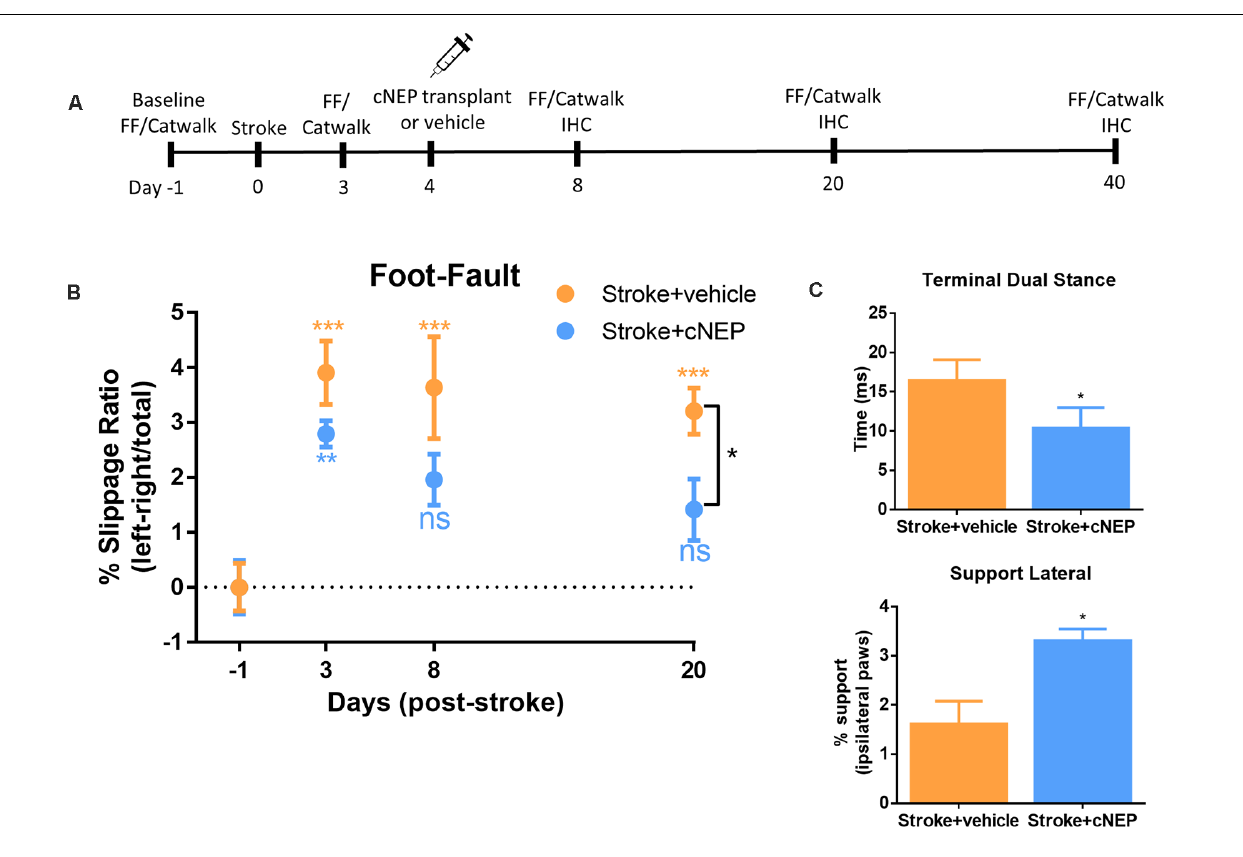
FIGURE 2 | cNEP transplantation improves motor outcomes of stroke by PSD20. (A) Schematic of experimental paradigm. FF, foot-fault and IHC, immunohistochemistry. (B) The percent slippage ratio was scored in Stroke + vehicle and Stroke + cNEP treated mice. Both groups display a motor deficit on PSD3 and PSD8 compared to baseline performance. Stroke + cNEP mice recover by PSD8 and PSD20 when compared to baseline and is significantly improved compared to Stroke + vehicle mice (Student’s T -test, Mann–Whitney post hoc ). Stroke + vehicle mice maintain the stroke motor deficit on PSD8 and PSD20, compared to baseline. Stroke + cNEP ( n = 10 mice); Stroke + vehicle ( n = 10 mice) Two-way ANOVA, Tukey’s post hoc . (C) Catwalk was used to measure gait parameters after stroke with or without cNEP transplantation. Terminal dual stance measures the duration (ms) of simultaneous contact of both hindpaws. The duration of the left hindlimb terminal dual stance was significantly increased in Stroke + vehicle mice compared to Stroke + cNEP mice. Support lateral is a measurement of the time when ipsilateral paws (lateral forelimb and hindlimb) make simultaneous contact during the walking task Stroke + vehicle mice exhibited significantly impaired support lateral gait pattern compared to Stroke + cNEP treated mice ( n =6 mice/group). All statistics were performed with Two-way ANOVA, Tukey’s post hoc . Data shown as mean ± SEM. ns, not significant; * p < 0.05, ** p < 0.01, *** p <